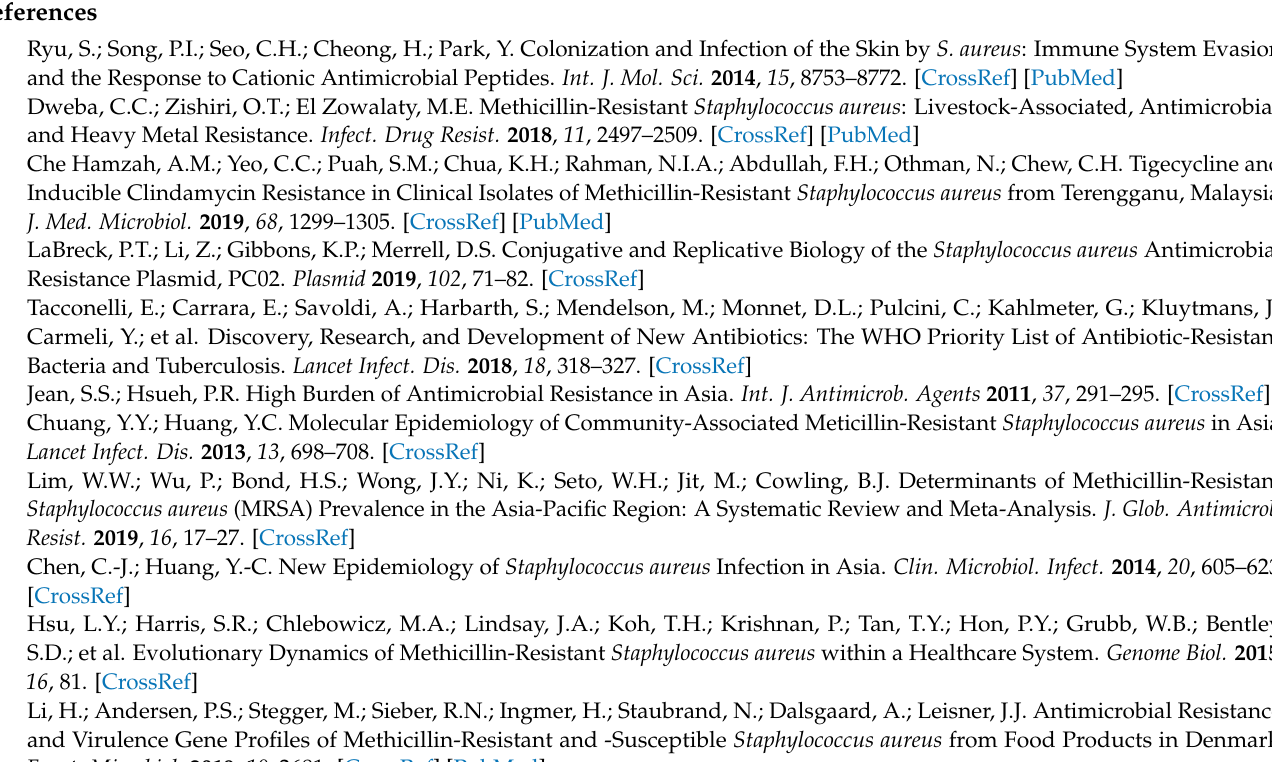
Table S2: list of primers used for gap closures and sequence validation of identified plasmids. Figure S1: linear maps of the plasmid types that were found in the present